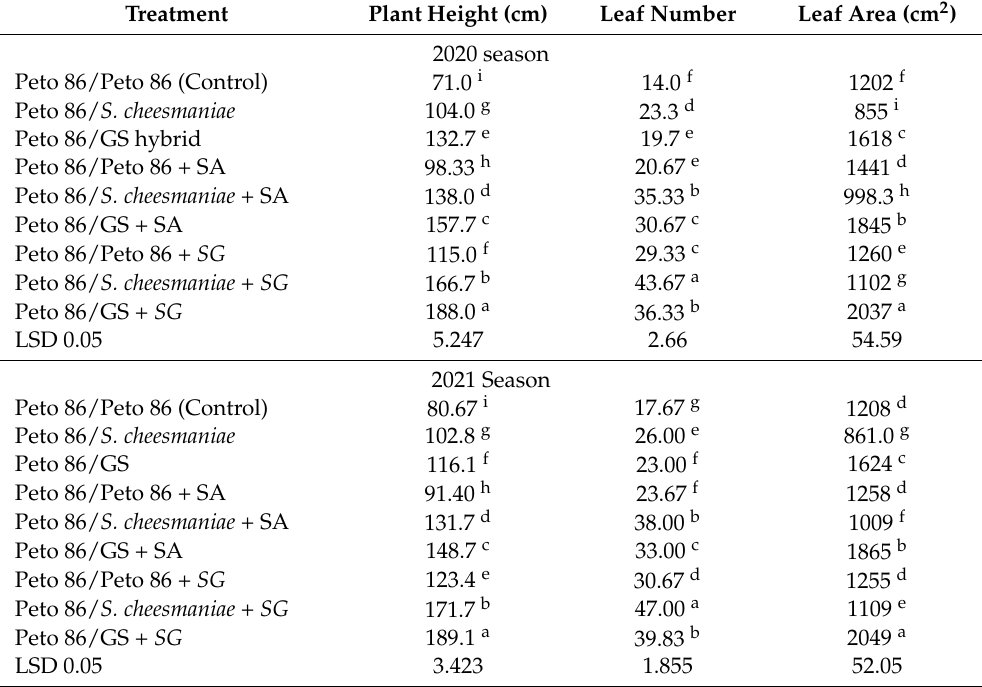
Table 1. Effects of grafting, rootstock seed treated with shikimic acid (SA), and colonisation with Streptomyces griseus (SG) on tomato plants growth during 2020 and 2021 seasons.